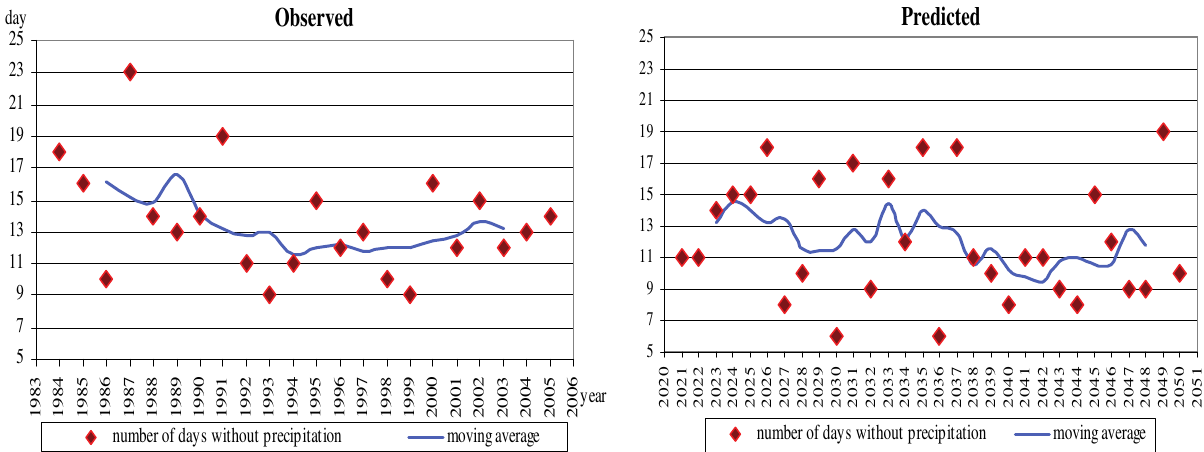
Figure 6: Number of days without precipitation at Újfehértó as observed (Left) and estimated (Right) by the RegCM 3.1, for the 10 days + blooming period